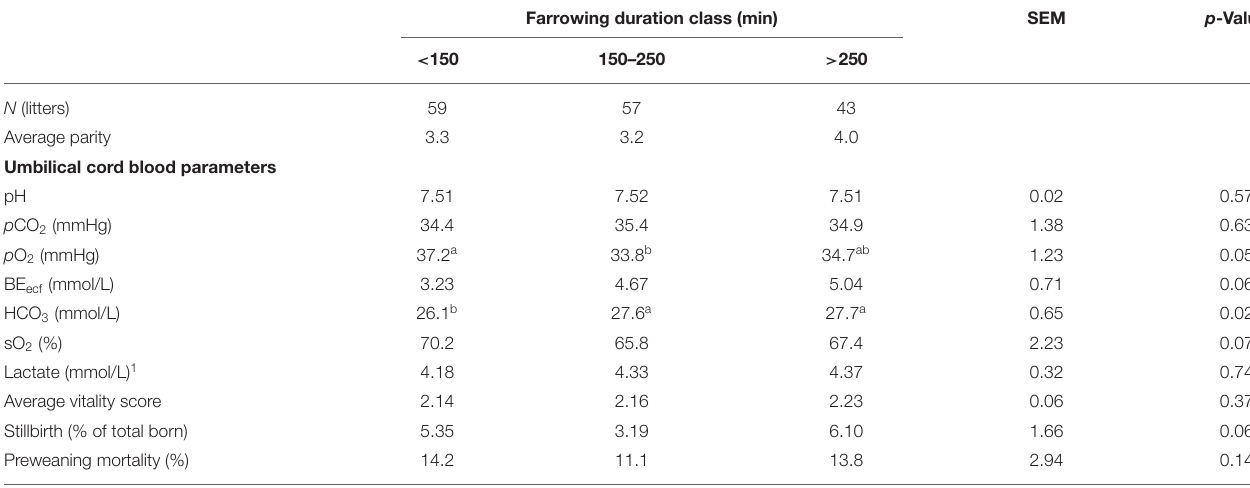
TABLE 2 | Effects of farrowing duration class on umbilical cord blood parameters immediately after birth, vitality of piglets, incidence of stillbirth, and preweaning mortality (LSmeans ±